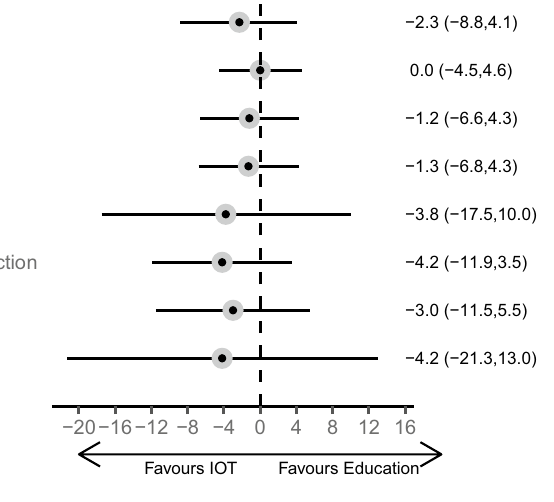
Figure 2. Mean DASS scores across three time-points, by arm.